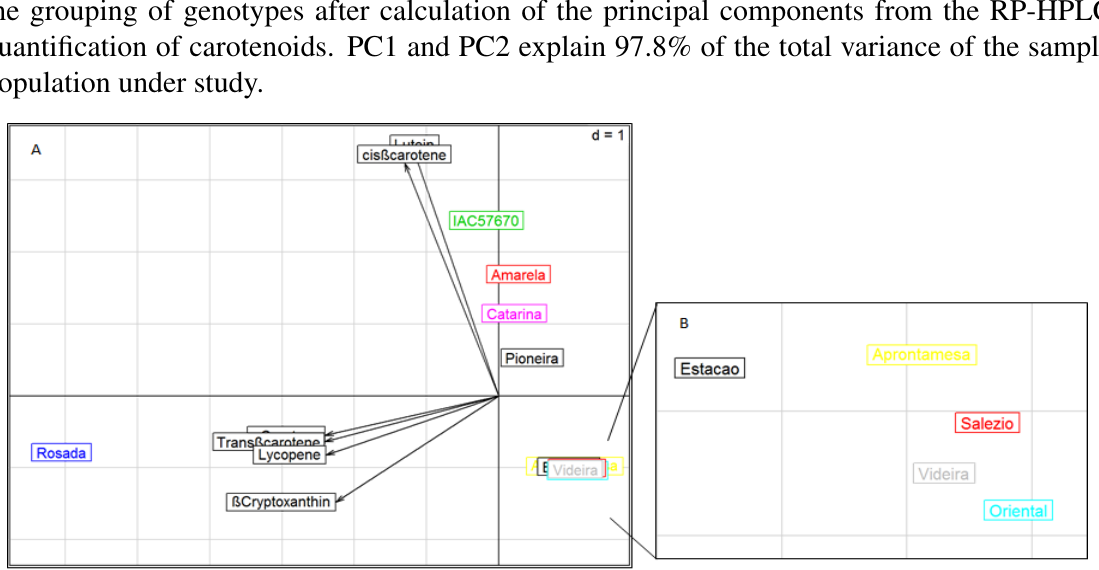
Figure 6: A - Scores scatter plot (PC1 and PC2) of the quantitative data of carotenoids determined by RP-HPLC in root samples of ten cassava genotypes (n = 3). B - Magnification to the overlapping samples at the